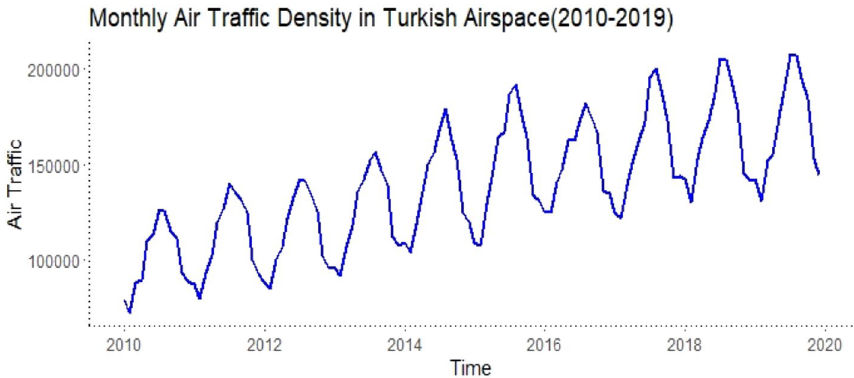
Figure 2. Graphical representation of monthly air traffic data for the years 2010–2019.